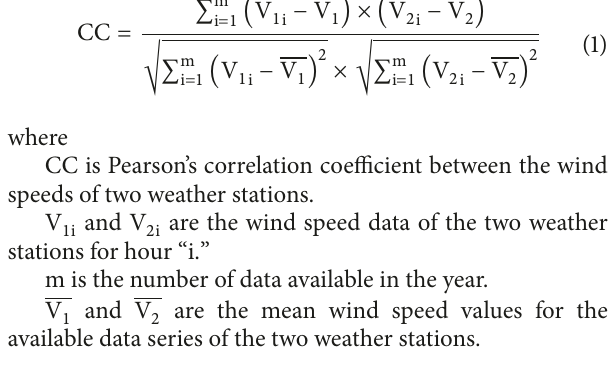
Figure 2: Distribution of wind turbines of WF-2 on Lanzarote [29].